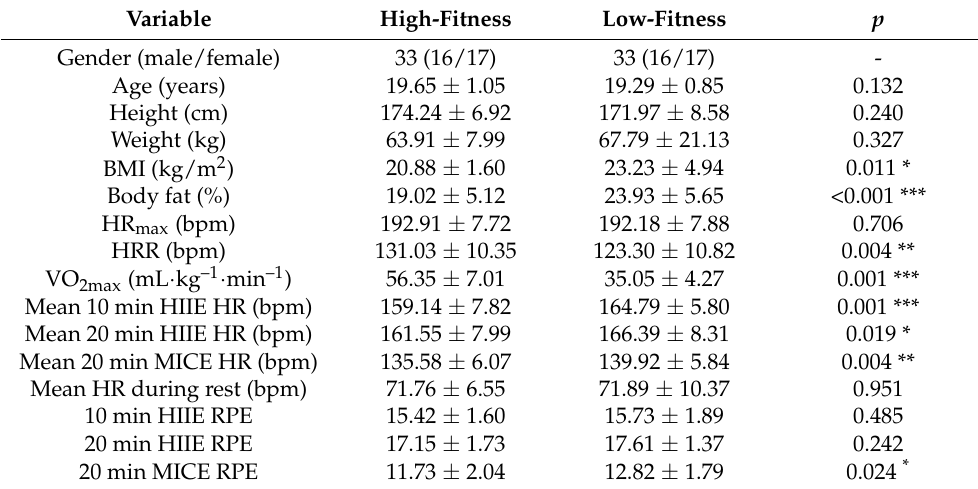
Table 1. Descriptive data of the high- and low-fitness groups ( Mean ± Standard Deviation ). Variable High-Fitness Low-Fitness p Gender (male/female) 33